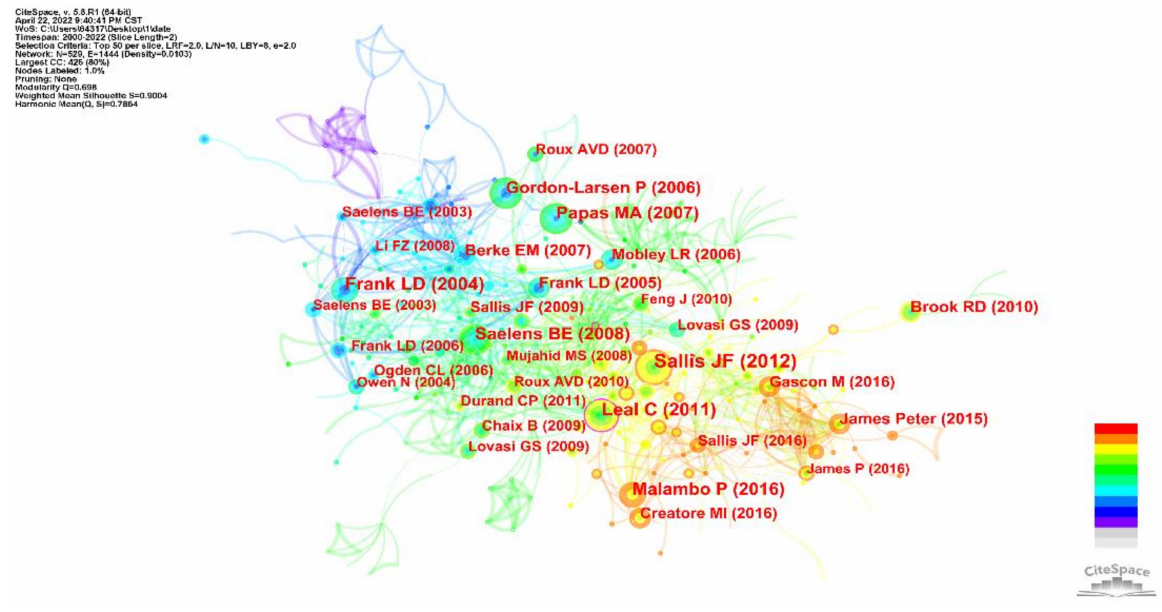
Figure 8. Knowledge map of co-citation